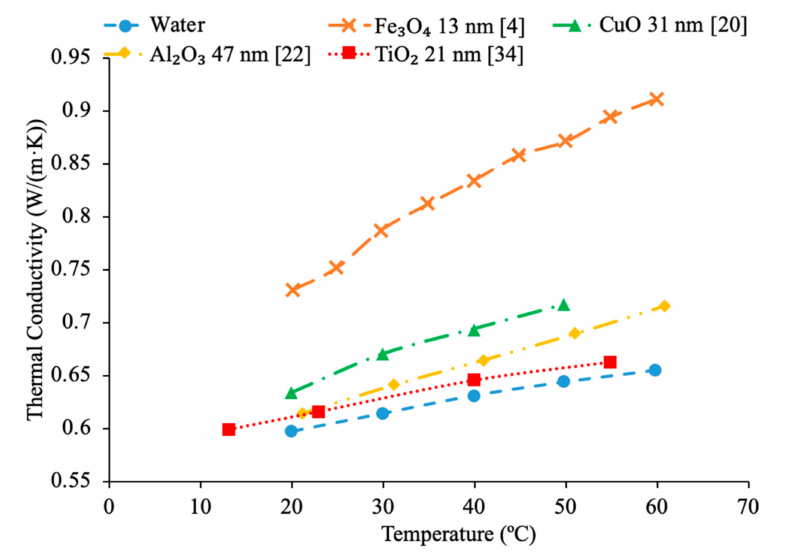
Figure 8. Thermal conductivity of water-based nanofluids of CuO, Fe 3 O 4 , Al 2 O 3 , and TiO 2 as a function of temperature with various sized nanoparticles of 13, 21, 31 and 47 nm